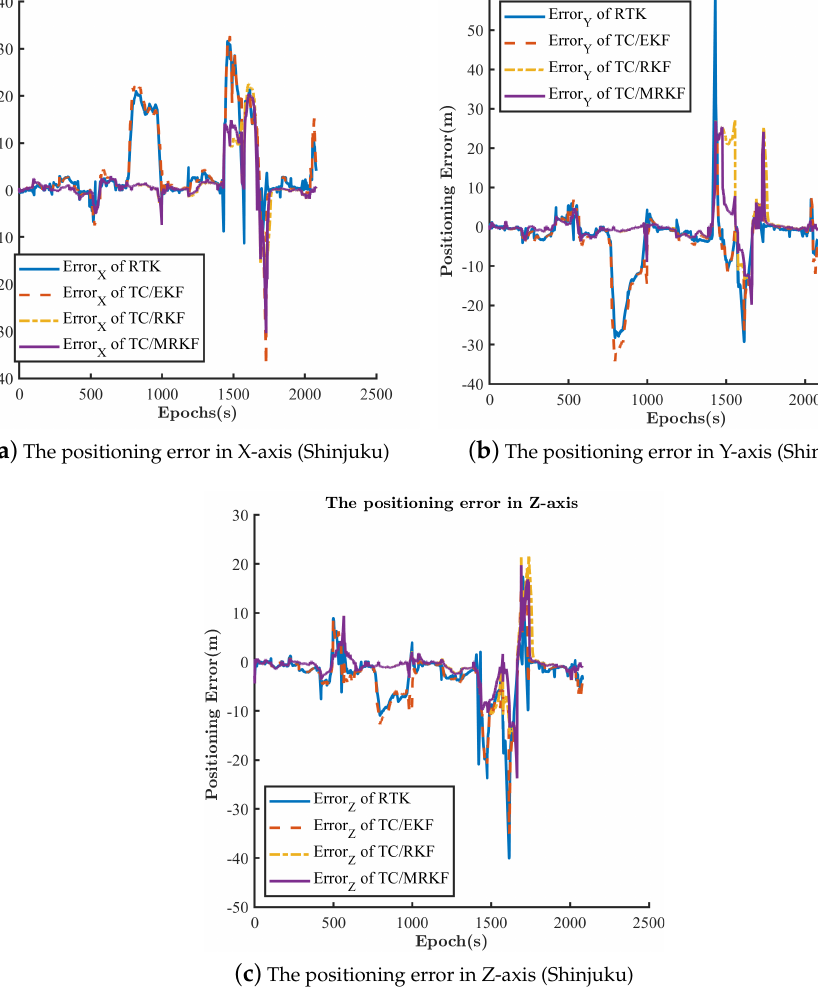
Figure 18. The position error in three dimensions